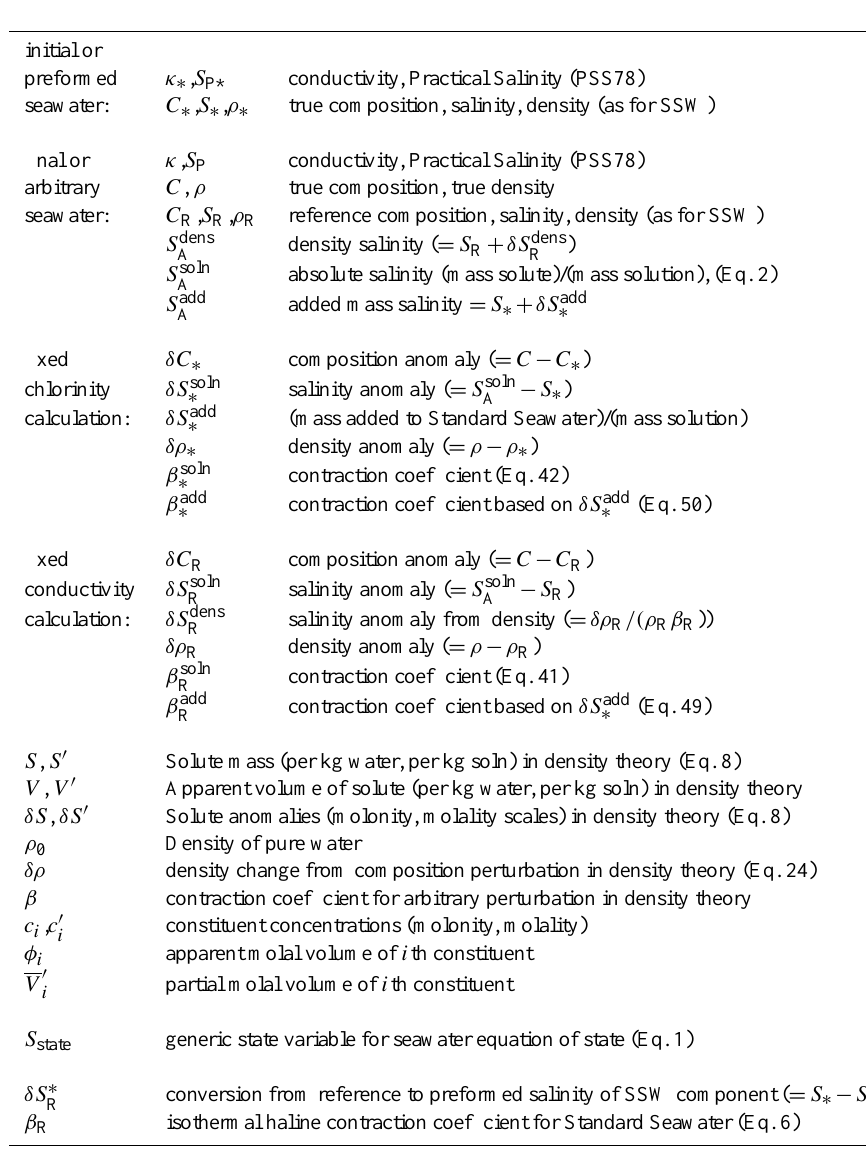
Table 1. Glossary of important symbols and